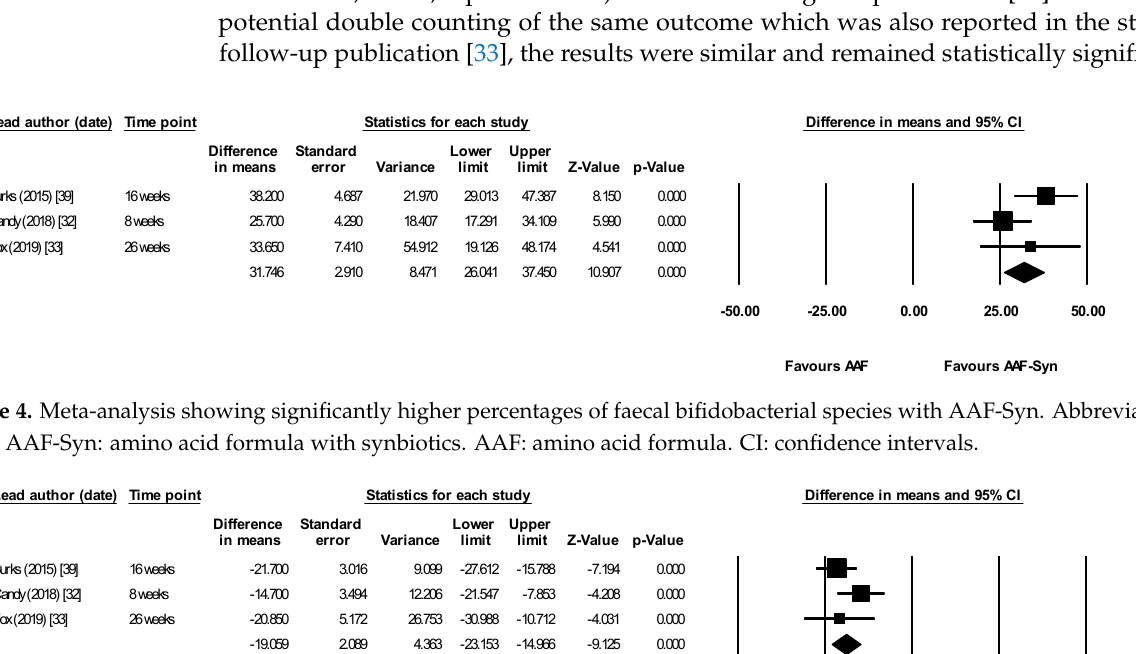
Nutrients 2021 , 13 , x FOR PEER REVIEW